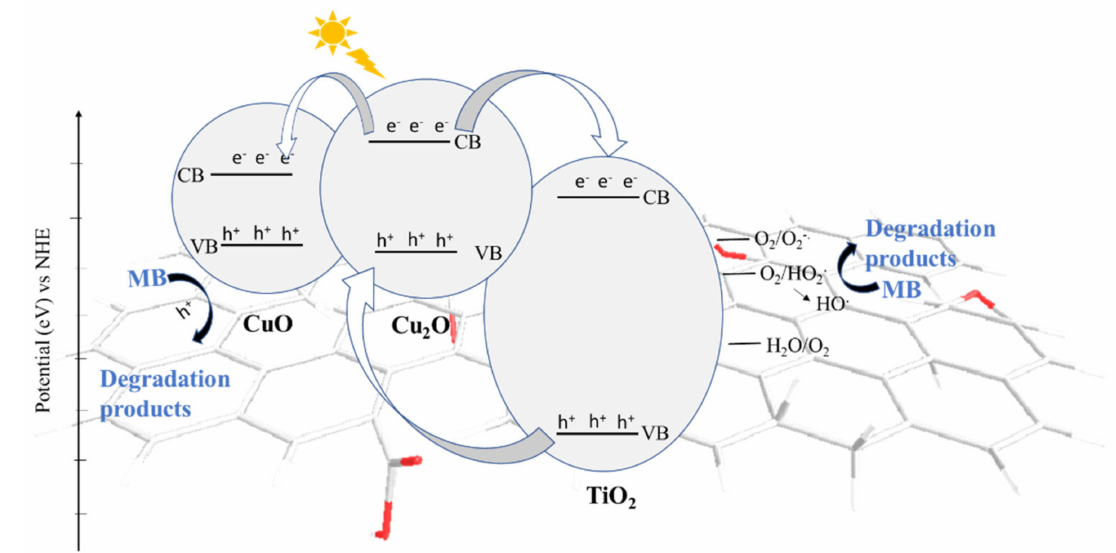
Figure 6. Schematic illustration for the Cu 2 O-CuO-TiO 2 heterojunction.